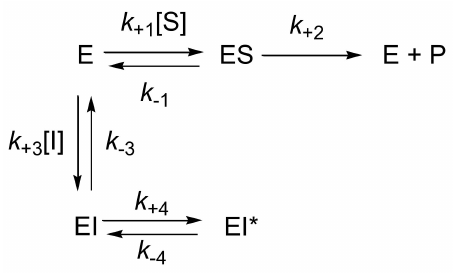
Figure 5. Slow-binding inhibition model of type